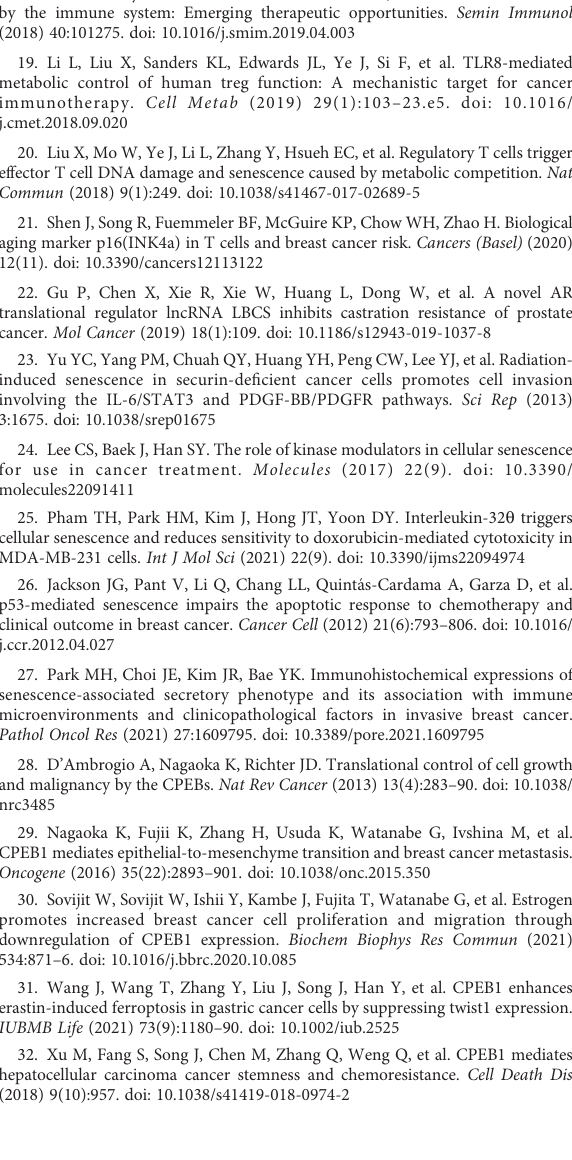
SUPPLEMENTARY FIGURE 2 Gene set enrichment analysis (GSEA). (A) Cellular senescence and aging were signi fi cantly enriched in Cluster A. (B) Cellular senescence and aging were signi fi cantly enriched in high risk group. SUPPLEMENTARY FIGURE 3 Relationships between the senescence-related score and pathological response to neoadjuvant